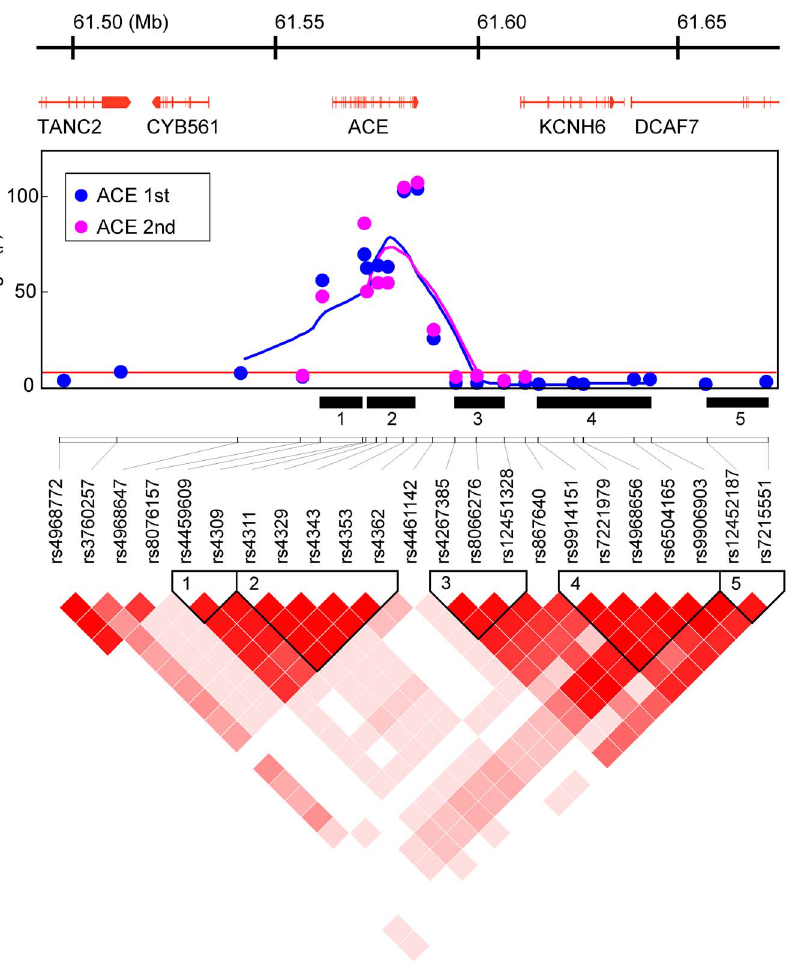
Figure 3. Gene map from RefSeq (upper panel), association pattern (middle), and LD structure (lower) by D 9 measure in the Takahata population, in the 183 kb region from 61,481,619 to 61,664,990 of 17q23.2, using the coordinate system of the human genomic DNA sequence (GRCh37/hg19). The association pattern is expressed by plots of 2 log(p-value) with lines connecting five-point moving averages for SNPs around the ABO and ACE1 loci in the Takahata (1st) and Yamagata (2nd) populations. The numbered black bars indicate LD blocks defined by a confidence-interval of D 9 measure that reflects those in the LD structure panel.